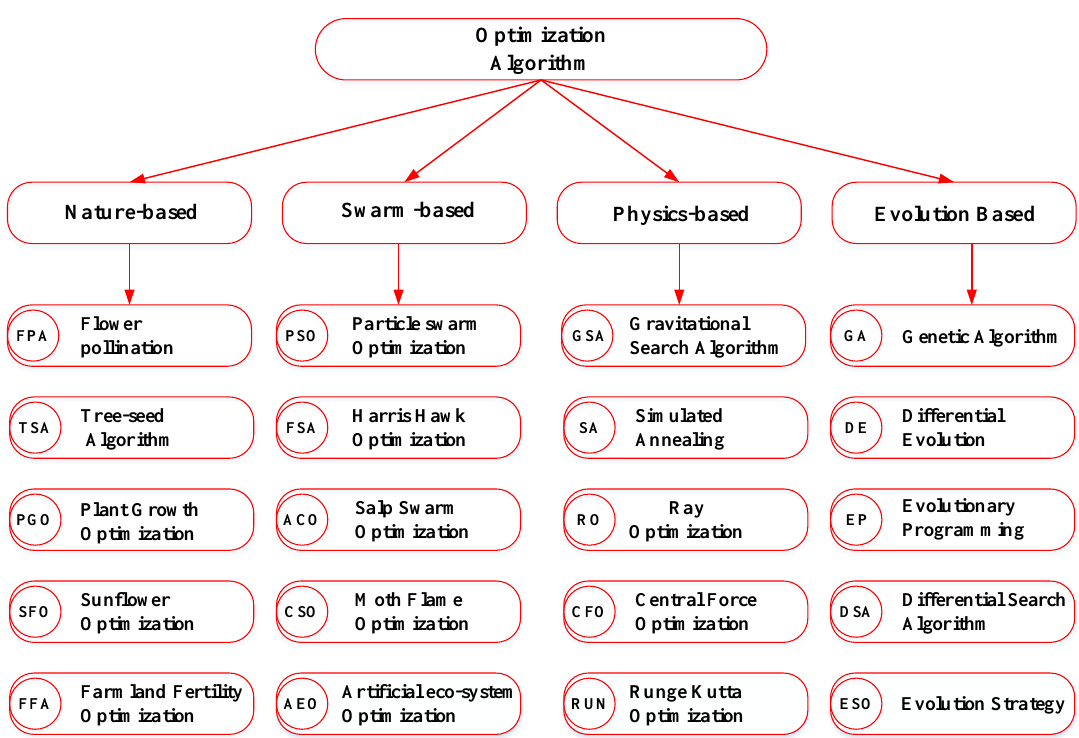
Figure 24. Broad classification of some meta-heuristic algorithms